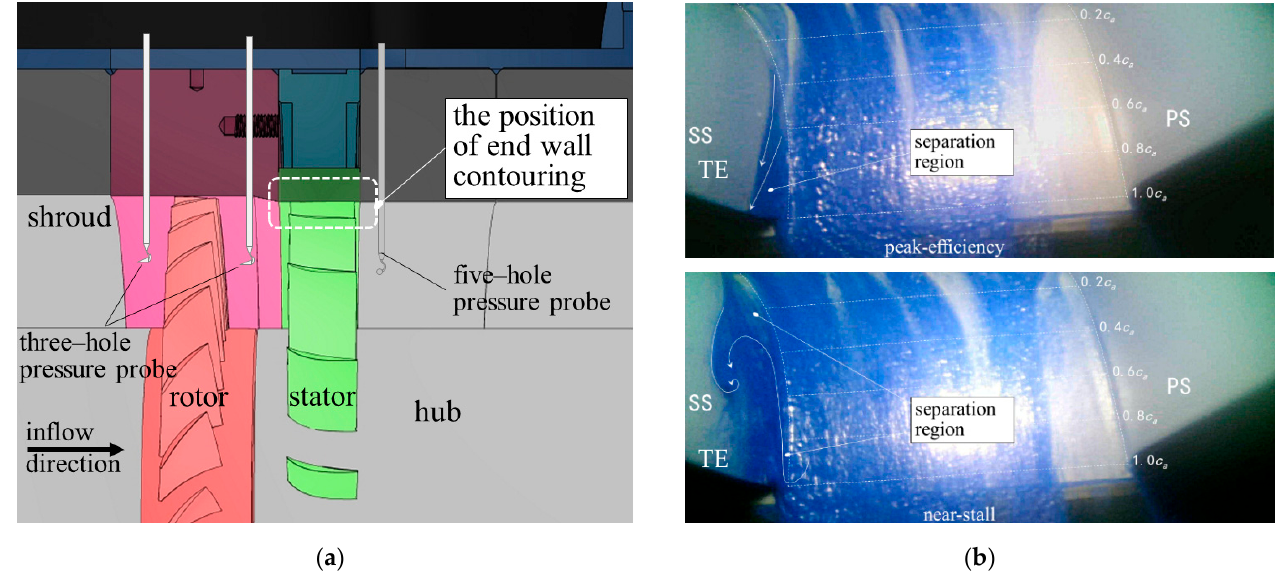
Figure 12. The compressor stage for the experiment. ( a ) Test rig; ( b ) Oil-flow in the corner region of casing end wall captured at 70% design speed (top: peak-efficiency point; bottom: near-stall point).